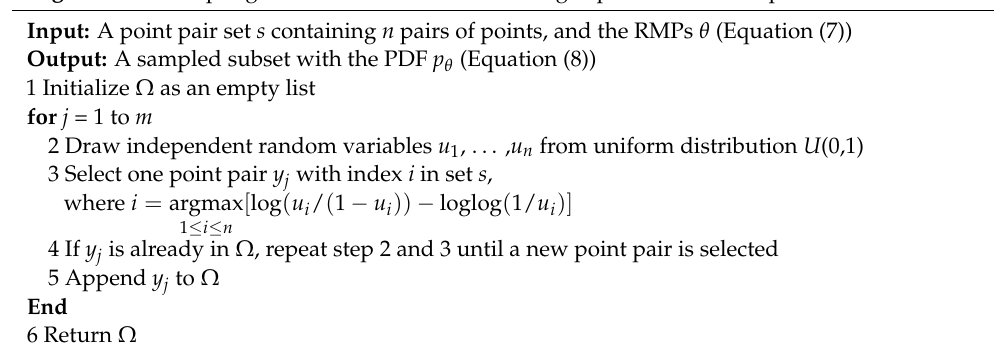
Algorithm 1: Sampling a minimal subset Ω containing m pairs of matched